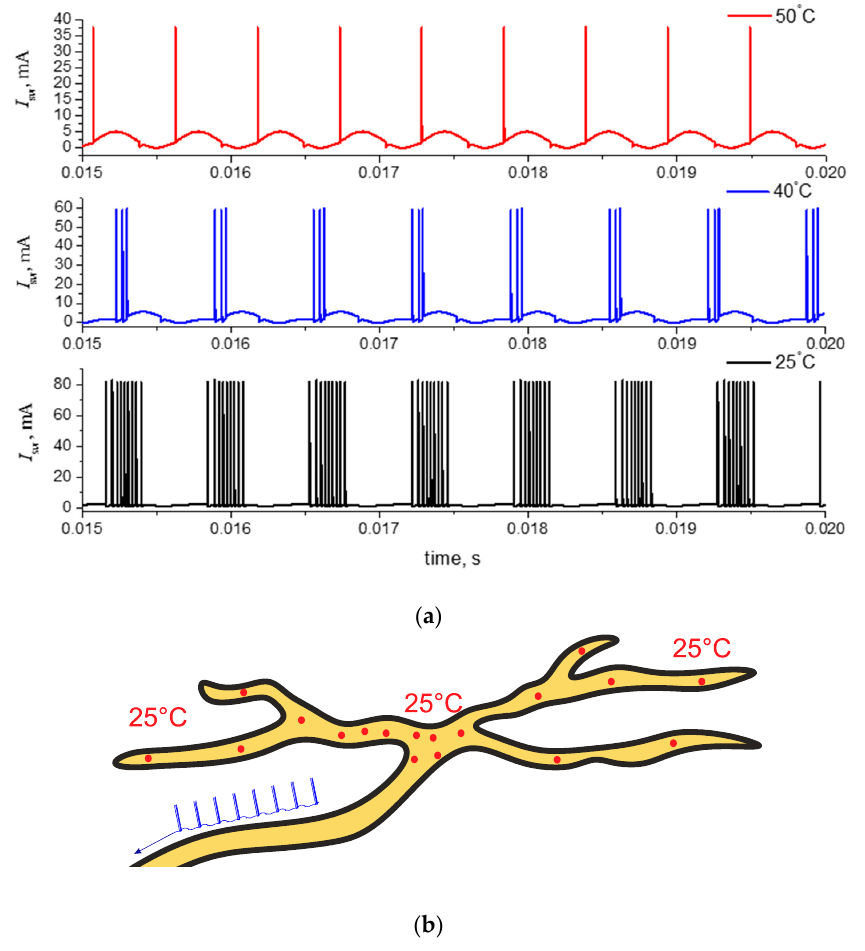
Figure 13. ( a ) Current oscillograms of the switching VO 2 element at different temperatures for the circuit in Figure 11b. Circuit parameters: I 0 = 2.5 mA, C 0 = 100 nF, C 1 = 20 nF, and L = 60 mH. ( b ) Schematic mapping of mammalian thermoreceptor at 25 ◦ C, adopted from